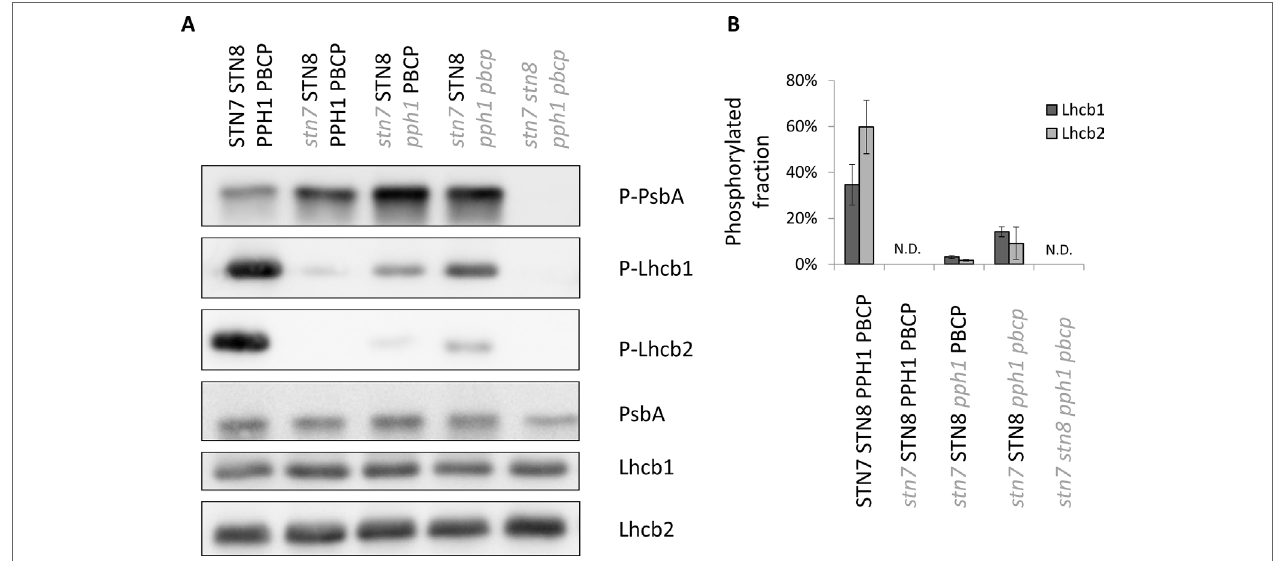
FIGURE 1 | Differential recovery of the phosphorylation level of Lhcb1 and Lhcb2 in multiple mutants. (A) The level of phosphorylation of the LHCII antenna and the core protein PsbA/D1 of PSII was assessed by immunoblotting with antibodies specifically recognizing the phosphorylated peptides. As a control, the total accumulation of the protein was also assessed by immunoblotting. (B) The phosphorylation level of Lhcb1 and Lhcb2 in 15 day-old plantlets was measured by quantification of the immunoblot signal after separation by Phos-tag PAGE. The average level of phosphorylation under 100 µmol photons m −2 s −1 is reported with its standard deviation (n = 3). The phosphorylation levels in the mutants is different from the WT, p values of a Welch T-test of the difference between the double ( stn7/ STN8 /pph1/ PBCP ) and the triple ( stn7/ STN8 /pph1/pbcp ) mutants are